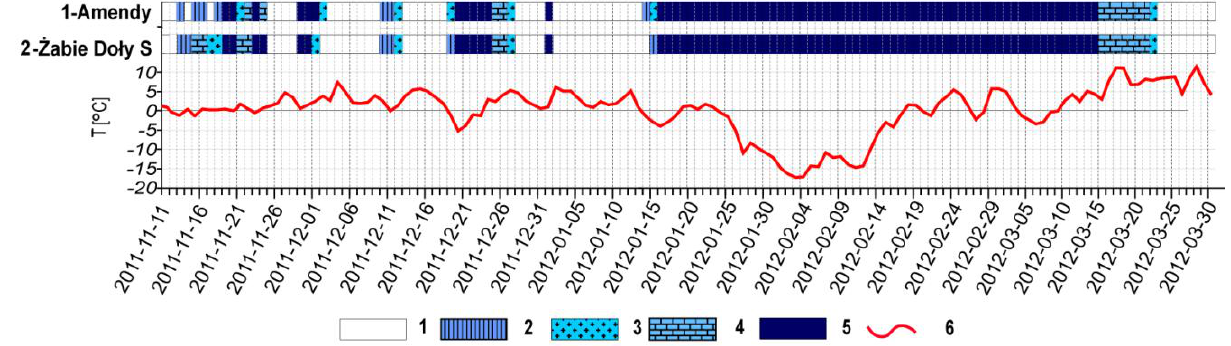
Fig. 2. The sequence of the particular phases of ice formation at the two water bodies in the winter season of 2011/2012 1 – no ice phenomena, 2 – shore ice, 3 – partial ice cover, 4 – incomplete ice cover, 5 – complete ice cover, 6 – average daily air